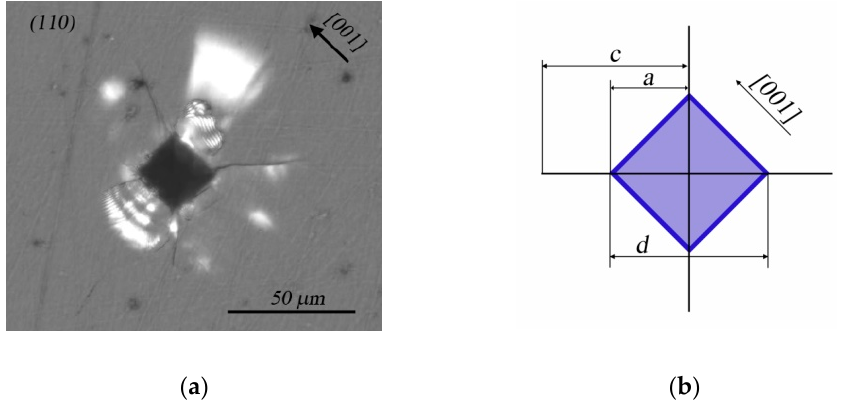
Figure 1. Image of indentation ( a ) and its scheme ( b ); d is the indentation diagonal, a is d /2, and c is the crack